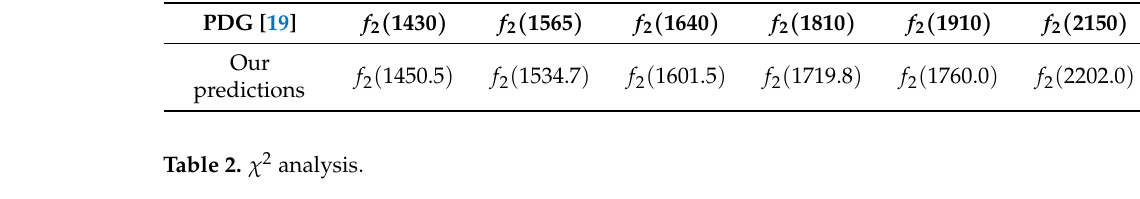
Table 1. Correspondence of the omitted f 2 resonances in the PDG [19] with our predictions.